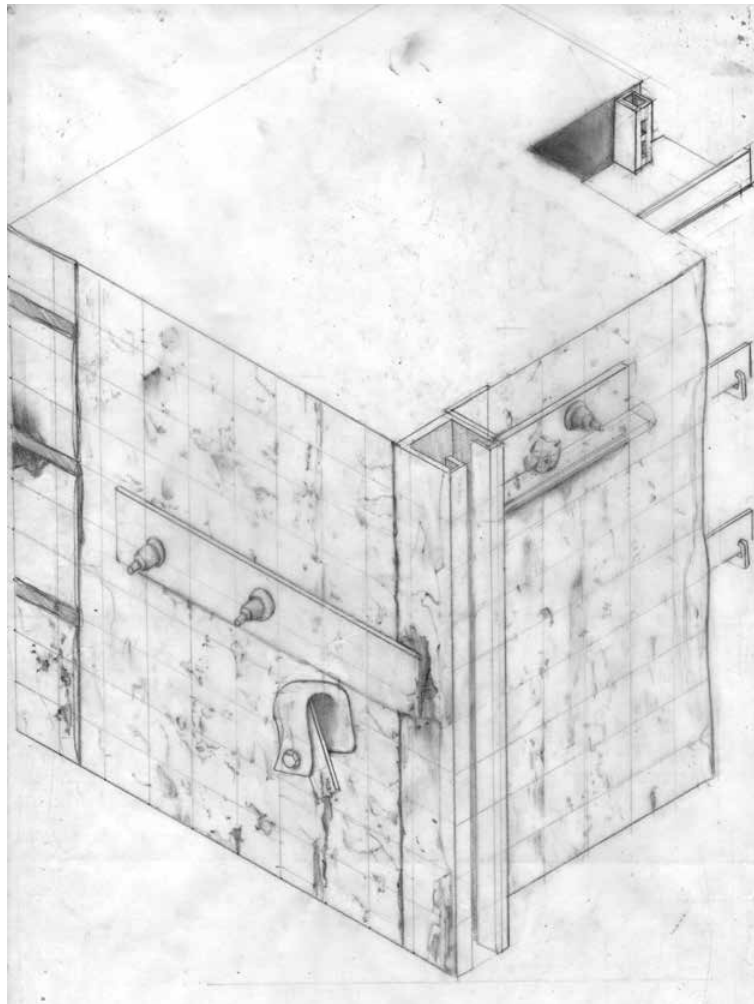
Figure 1 (Previous page): Vertical Studio Qamarah’ Eye - ‘City & the Interior’, 2016. Photographic collection. Source: Cheng Wai Yin, Lee Hiu Hei and Lai Hok Ming.